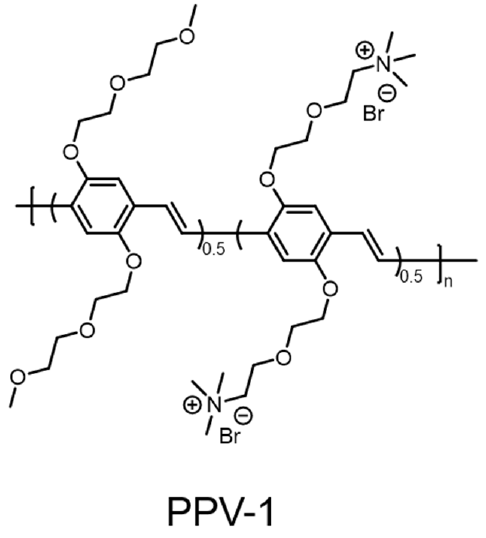
Figure 11. Chemical structure of PPV-1 for selective recognition, imaging, and killing of bacteria over mammalian cells.